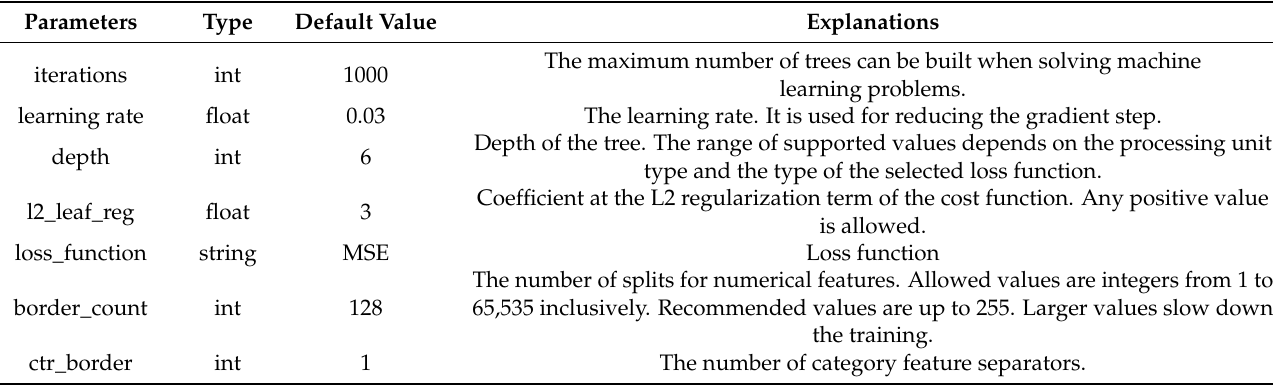
Table 2. Information on the main parameters of the CatBoost